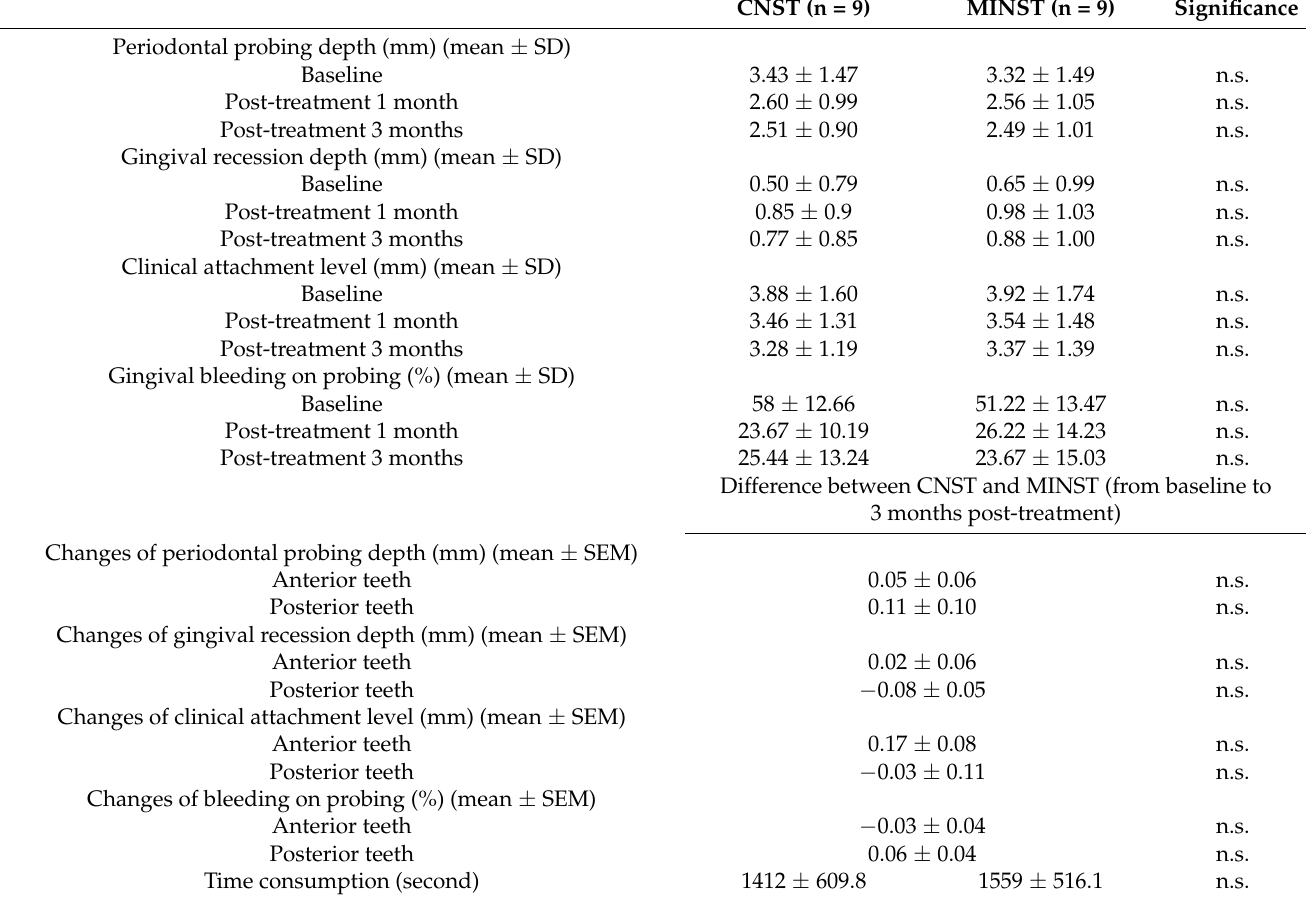
Table 2. Clinical outcomes of CNST and